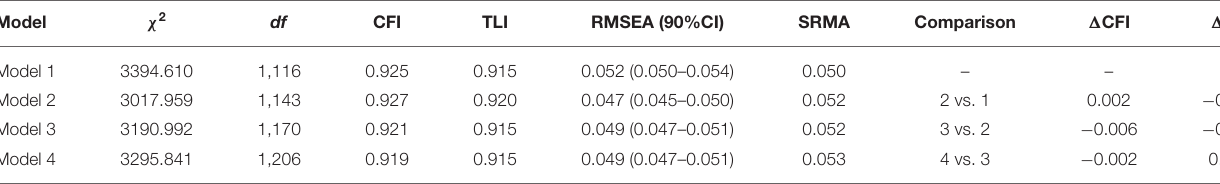
TABLE 6 | Measurement invariance of the CERQ-C across presence of depression. Model